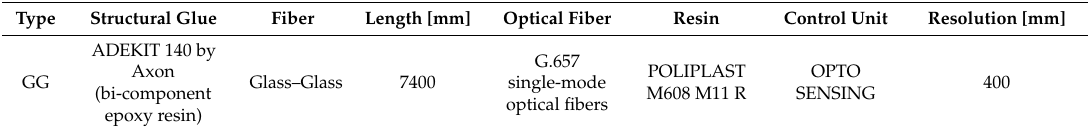
Table 2. First test: Specimen